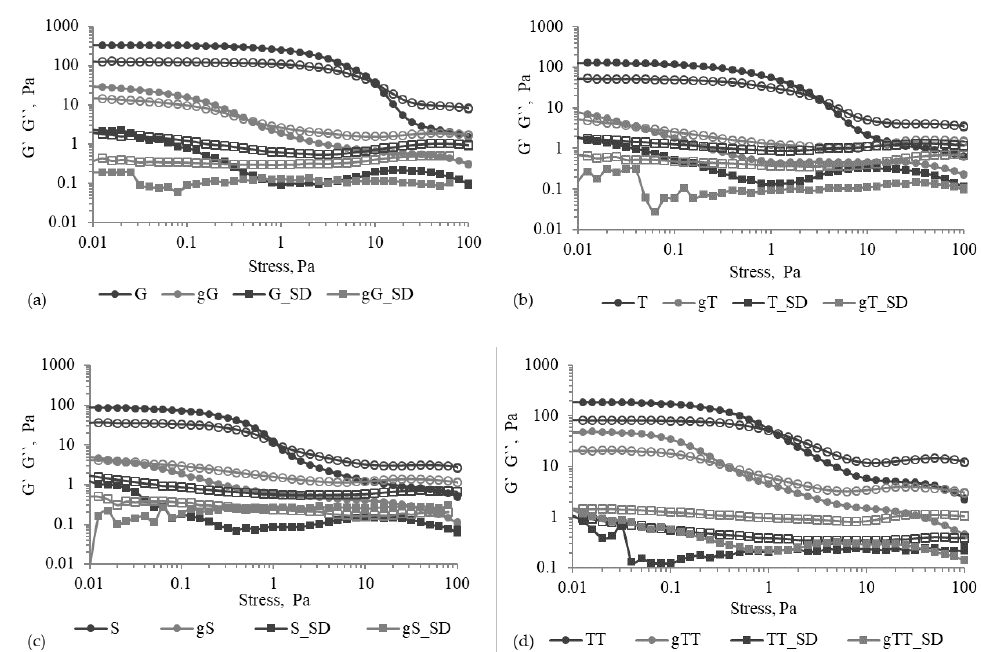
Figure 1. The evolution of the storage and loss moduli (G’ and G’’) during the oscillatory stress sweep test for the suspensions and sourdoughs prepared with the wholemeal flours obtained by milling Gabriela ( a ), Trivale ( b ), Spelt ( c ) and Triticale ( d ) grains. Tests were performed on suspensions prepared using flours from raw (G, T, S and TT) or germinated grains (gG, gT, gS and gTT) and on corresponding sourdough samples (G_SD, T_SD, S_SD and TT_SD prepared out of G, T, S and TT flours and gG_SD, gT_SD, gS_SD and gTT_SD prepared out of gG, gT, gS and gTT flours). Full and open symbols are used for presenting the evolution of G’ and G’’, respectively. Table 1. Yield stress, corresponding to the crossover point of storage modulus and loss modulus, for wheat (Gabriela, Trivale, Spelt) and triticale-based suspensions and sourdoughs.